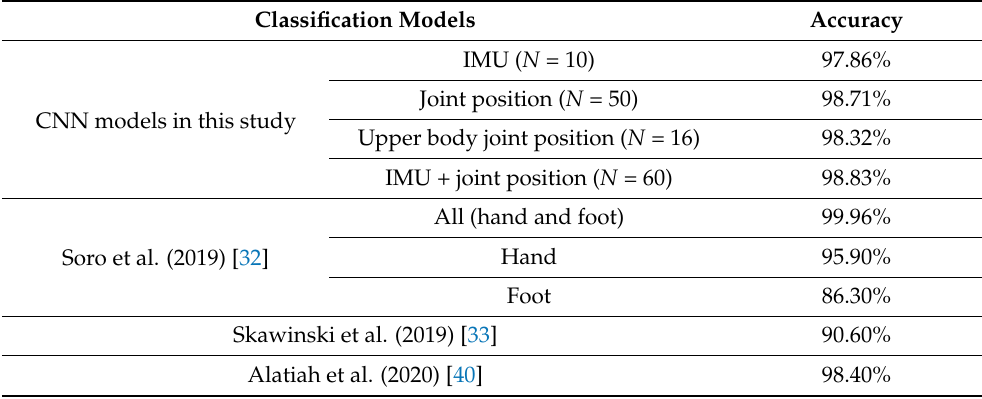
Table 15. Accuracies of the CNN models for the four exercise datasets and comparison with other studies